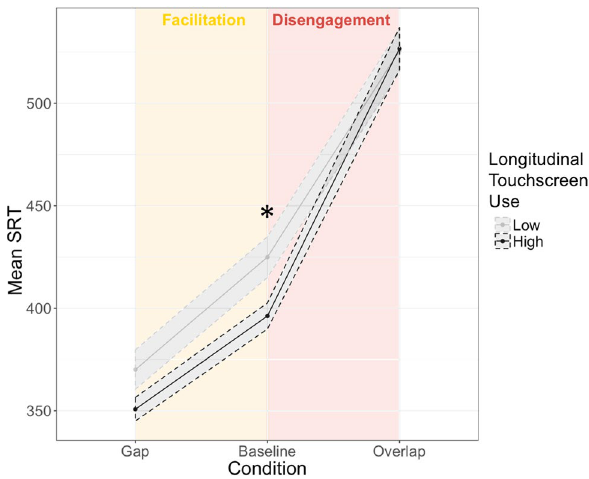
Figure 1. Mean Saccadic Reaction Time (ms) for each touchscreen use group (N = 40) as a function of trial condition in the Gap-Overlap Task. Measures are aggregated across the three longitudinal visits. Shaded areas represent standard error of the mean. *p <